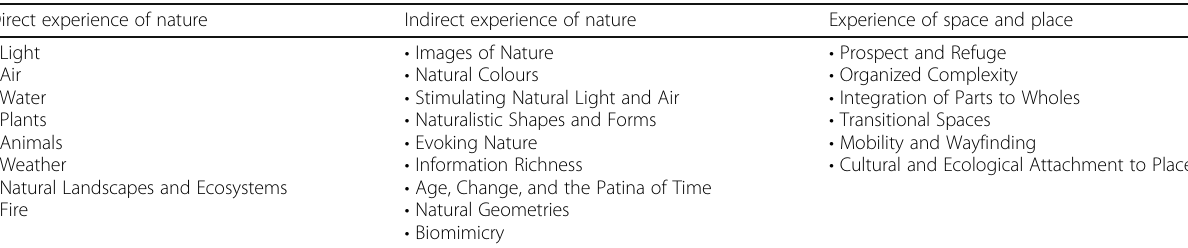
Table 2 Experiences and attributes of biophilic design. Source: Kellert and Calabrese (2015) Direct experience of nature Indirect experience of